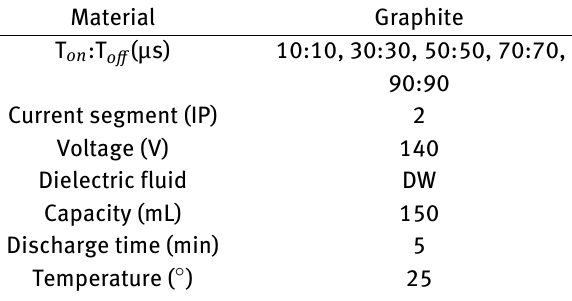
Table 1: Environmental parameter settings